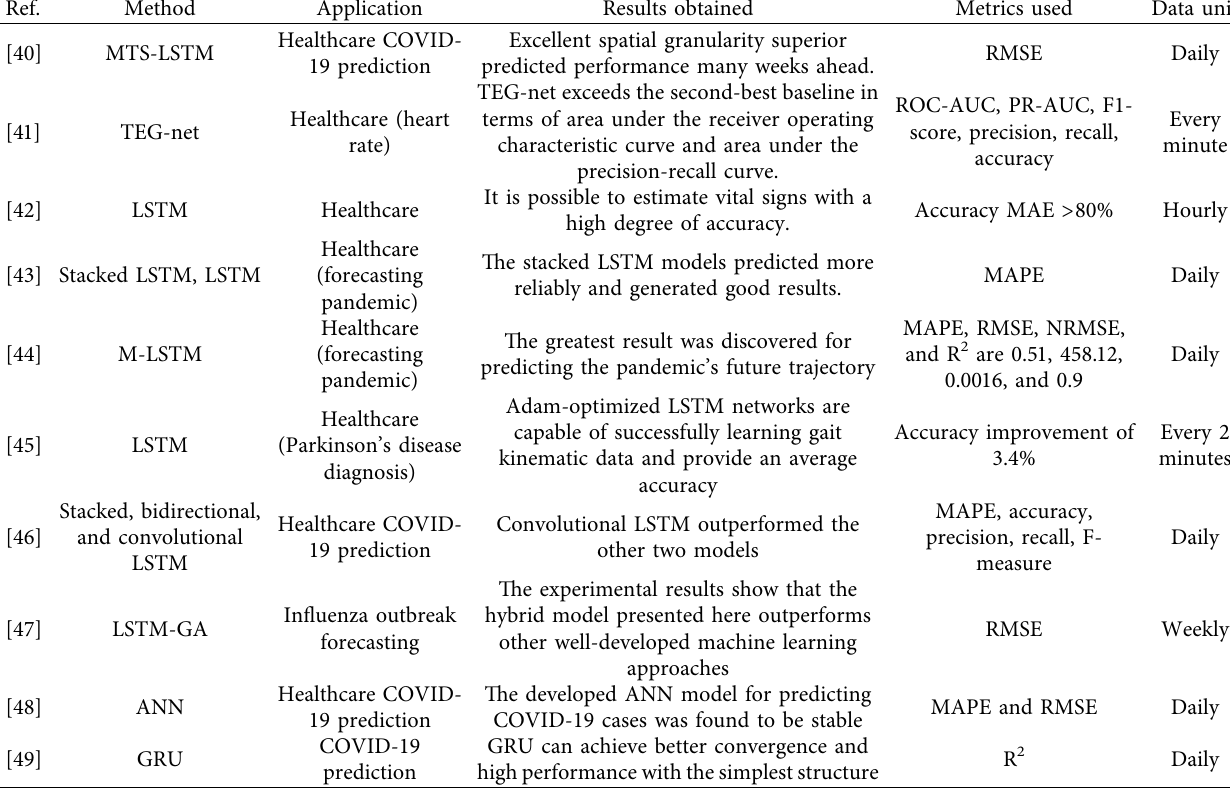
Table 1: A summary of published articles that used deep sequential models in healthcare predictions.